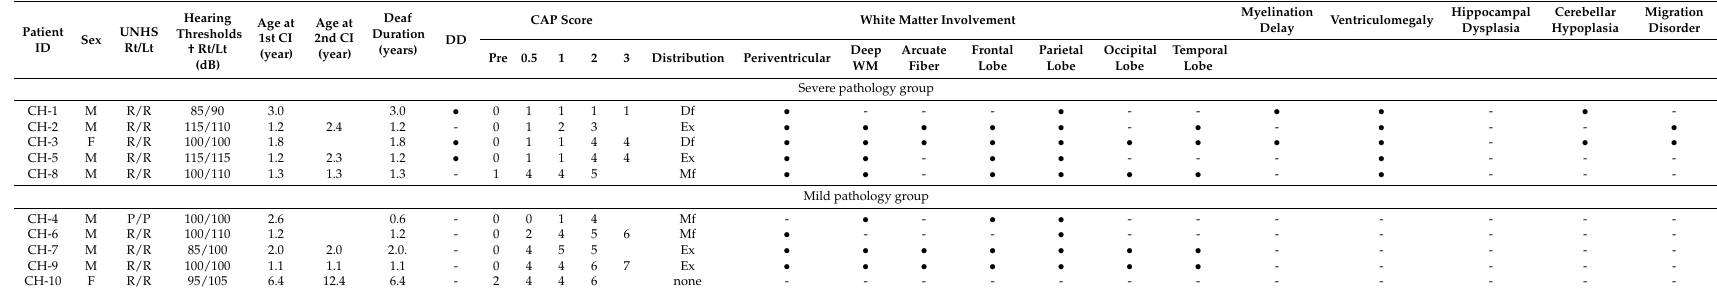
Table 1. MRI findings detected in patients with congenital cytomegalovirus infection and the outcome of cochlear